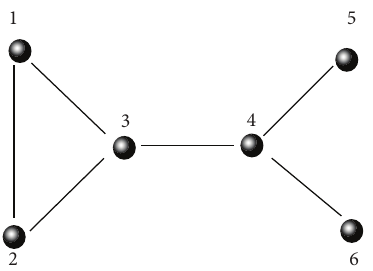
Figure 1: A simple network